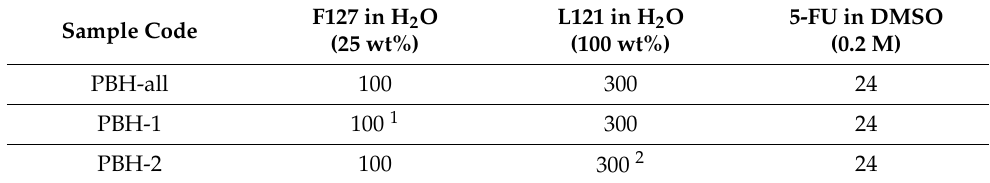
Table 1. The composition in volume ( µ L) of the pluronic biomedical hydrogels (PBHs). Sample